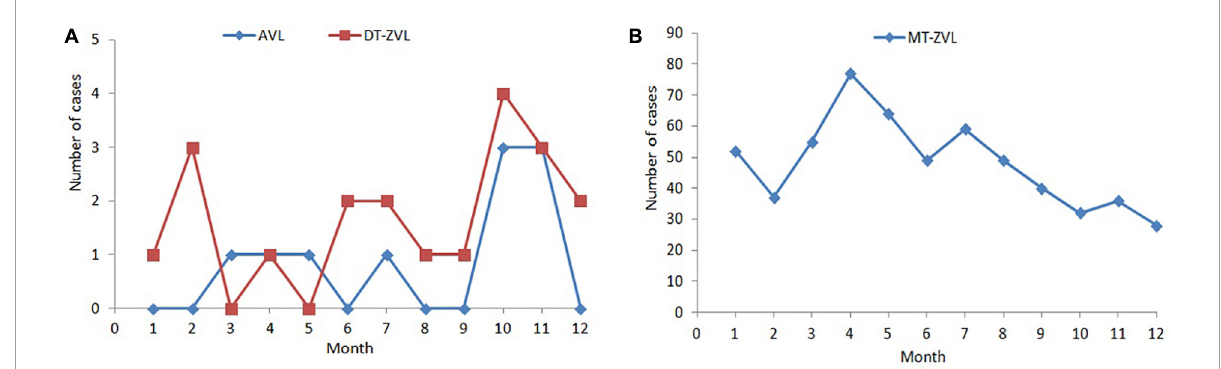
FIGURE1 Monthly distribution of visceral leishmaniasis cases in China between 2019 and 2021. (A) Monthly distribution of anthroponotic visceral leishmaniasis and desert-type zoonotic visceral leishmaniasis cases. (B) Monthly distribution of mountain-type zoonotic visceral leishmaniasis.